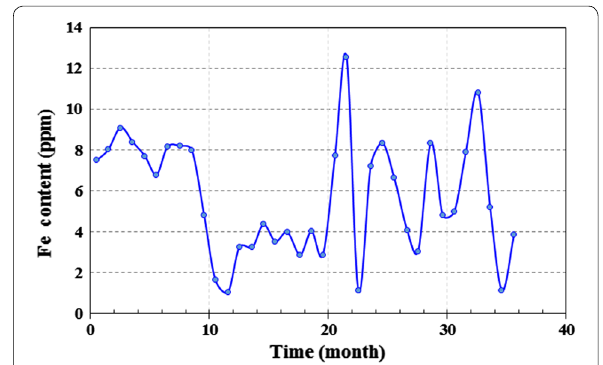
Fig. 7 Total Fe content throughout the 36 months in amine gas sweetening